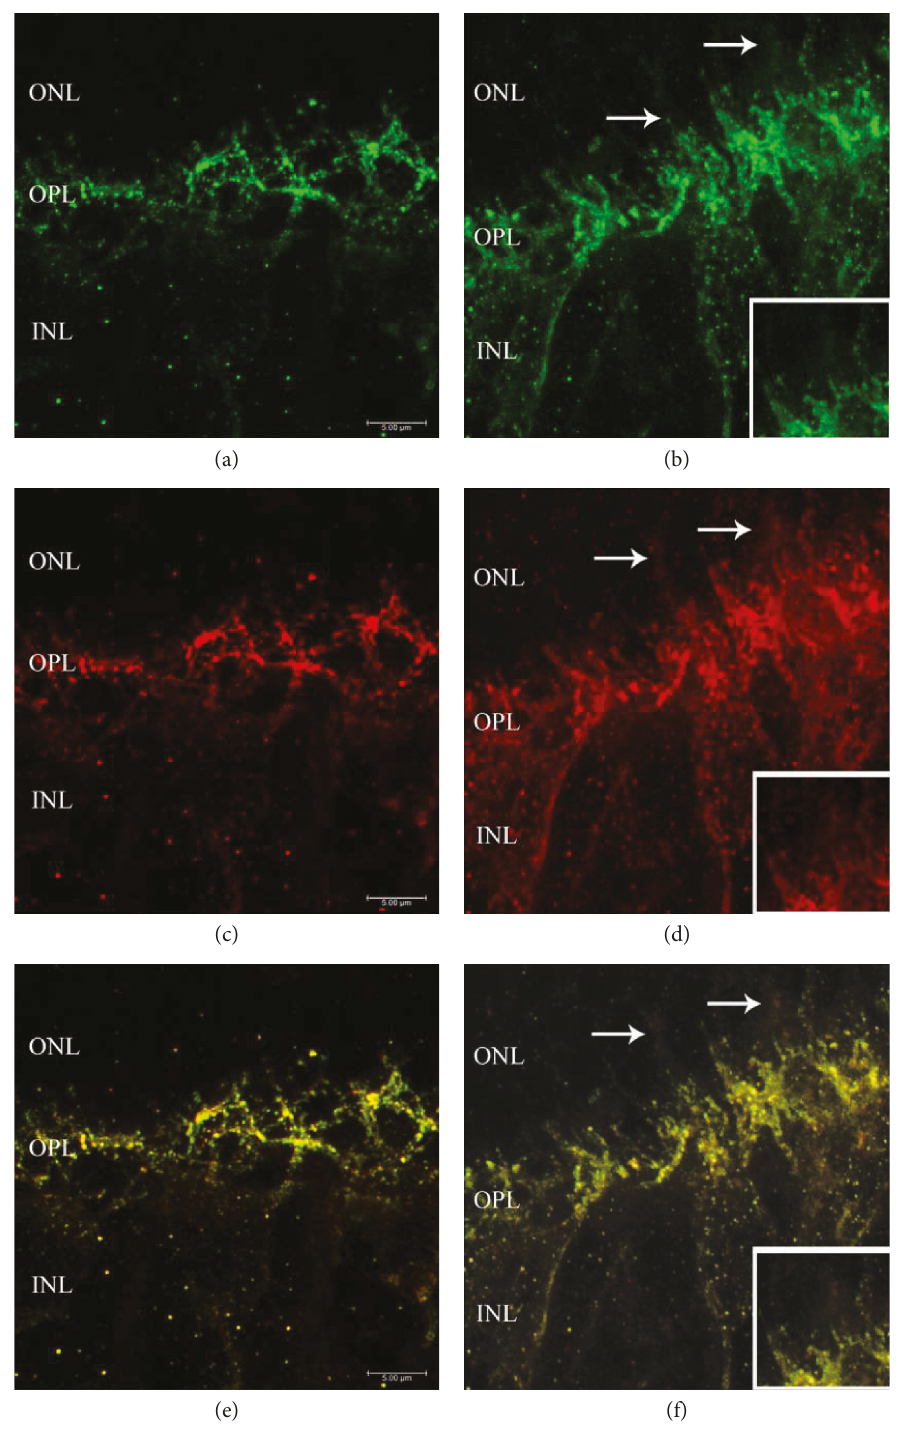
Figure 8: Expression of photoreceptor ribbon synapse protein Bassoon in a control (left column) and in an experimental retina (right column). Representative images of retinal sections labelled with PKC for mixed bipolar cells ((a), (b), green) and Bassoon for active ribbon synapse ((c), (d), red). Merged images are illustrated ((e) and (f)). ONL=outer nuclear layer, OPL =outer plexiform layer, and IPL =inner plexiform layer. Original magni fi cation × 63. Higher magni fi cation in the box ( ×